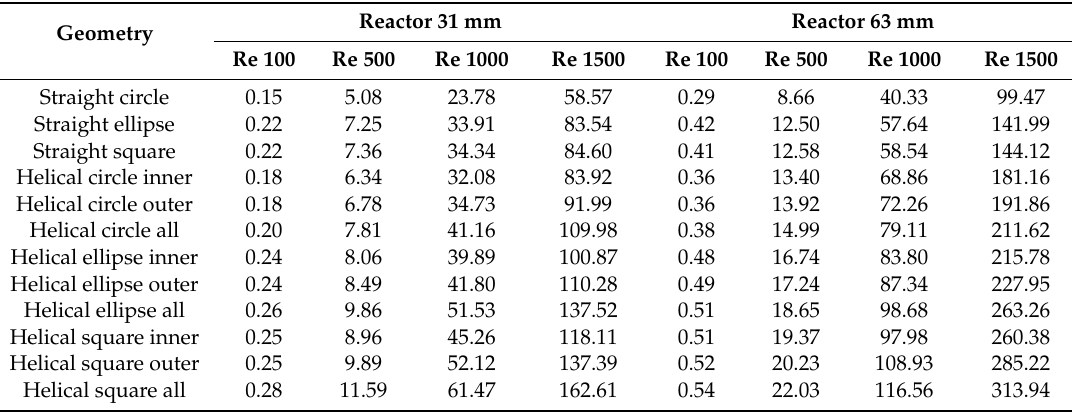
Table 6. Required pumping power for single channel reactor VAM reactor